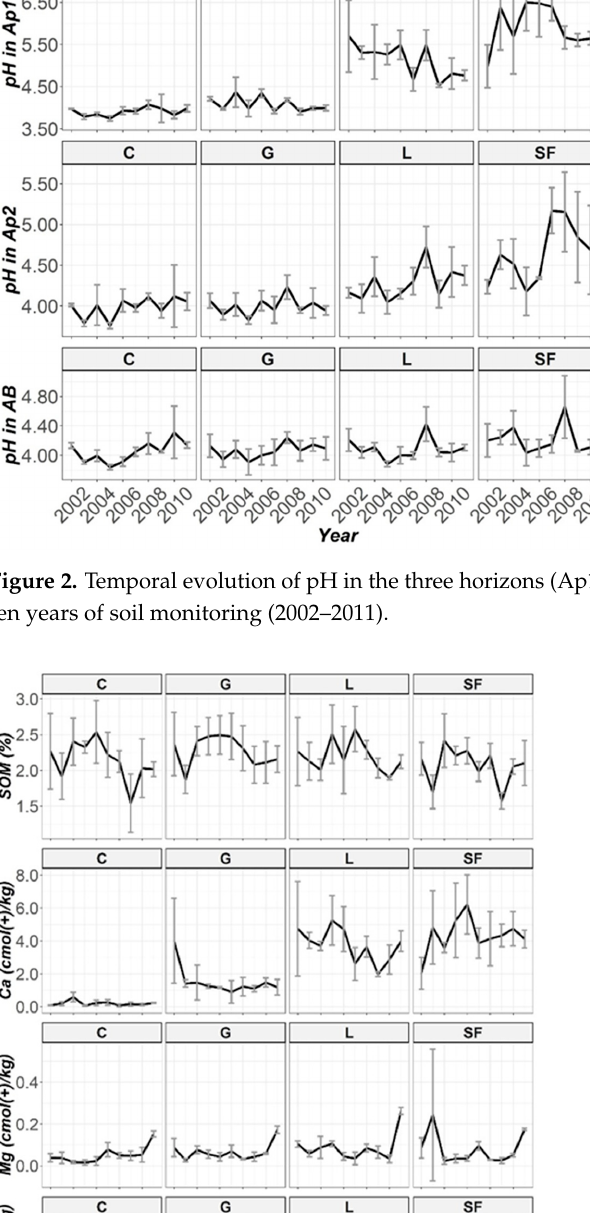
Figure 4. Temporal evolution of SOM, Ca, Mg and Al in the Ap2 horizon throughout the ten years of soil monitoring (2002–2011).